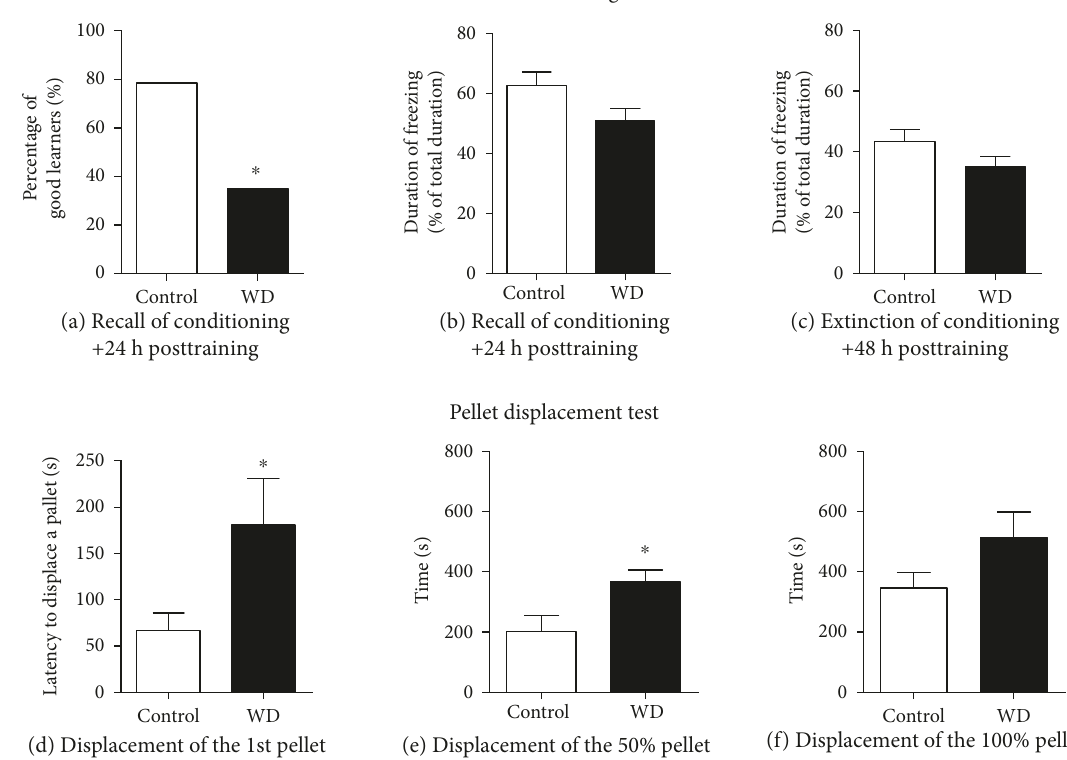
Figure 5: The high-cholesterol diet compromises the hippocampus-dependent performance. In the fear conditioning test, in comparison to control mice, the dietary-challenged group showed (a) signi fi cant decreased number of “ good learners ” ( ∗ p < 0 05 versus that in the control group, Fisher ’ s exact test), (b) a strong tendency to a reduced time spent with freezing during recall of conditioning ( p = 0 055 versus that in the control group, t -test), and (c) a signi fi cant decrease in time spent with freezing in a memory extinction protocol ( ∗ p < 0 05 versus that in the control group, t -test). In the pellet displacement tube test, in comparison to control animals, mice exposed to the cholesterol-enriched diet showed signi fi cantly prolonged (d) latency of a displacement of the 1st pellet and (e) the duration of displacement of 50% pellets ( ∗ p < 0 05 versus that in the control group, t -test) and (f) did not di ff er in the duration of a displacement of 100% pellets ( p > 0 05 versus that in the control group, t -test). Control — standard diet, WD — high-cholesterol diet. Data are shown as mean ±